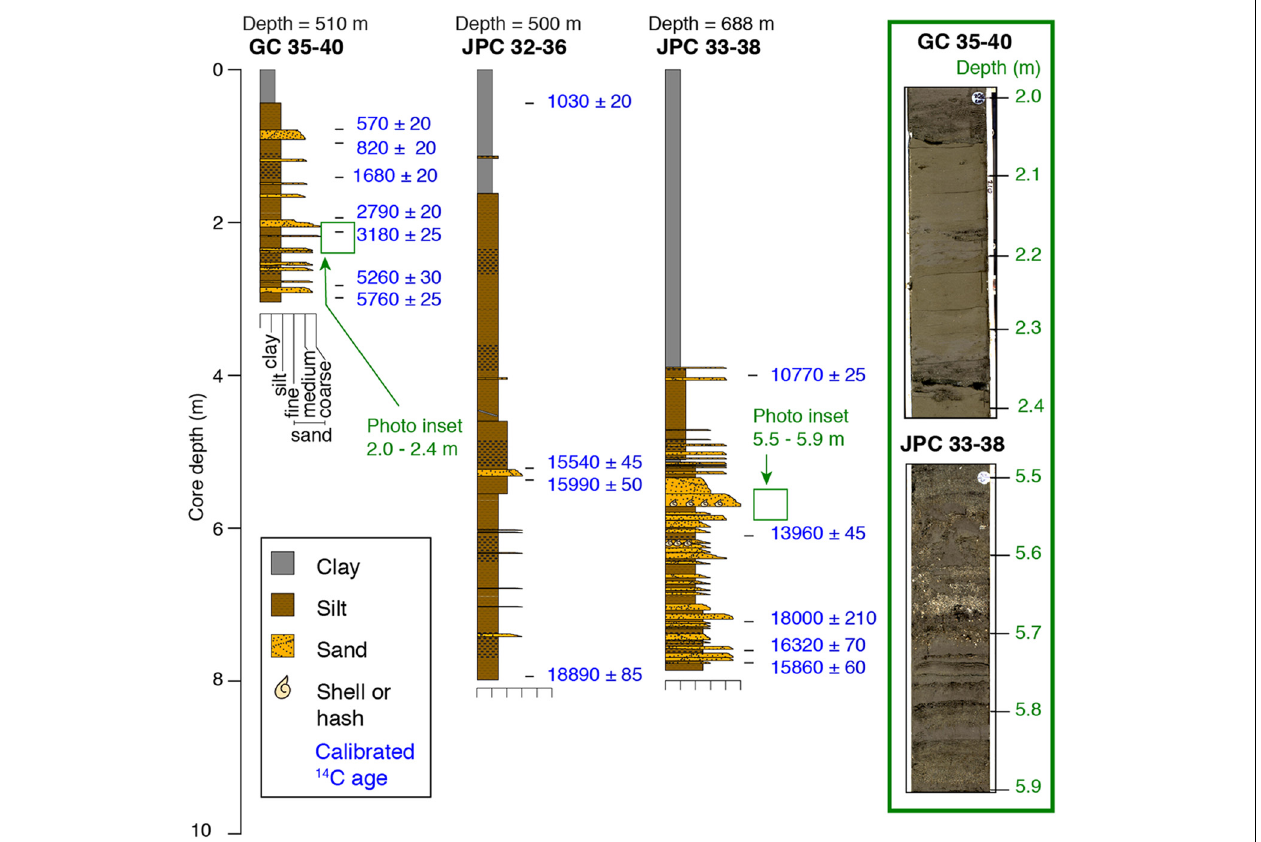
FIGURE 10 | Schematic diagrams of Dana Point cores. Grain size scale is shown under GC 35–40. Unlabeled grain size scales are shown below all other cores. Calibrated radiocarbon ages are shown to the right of the cores. At right, photo insets of select cores are plotted with their depth. The location of the photo insets are shown relative to core diagrams by the outlined green